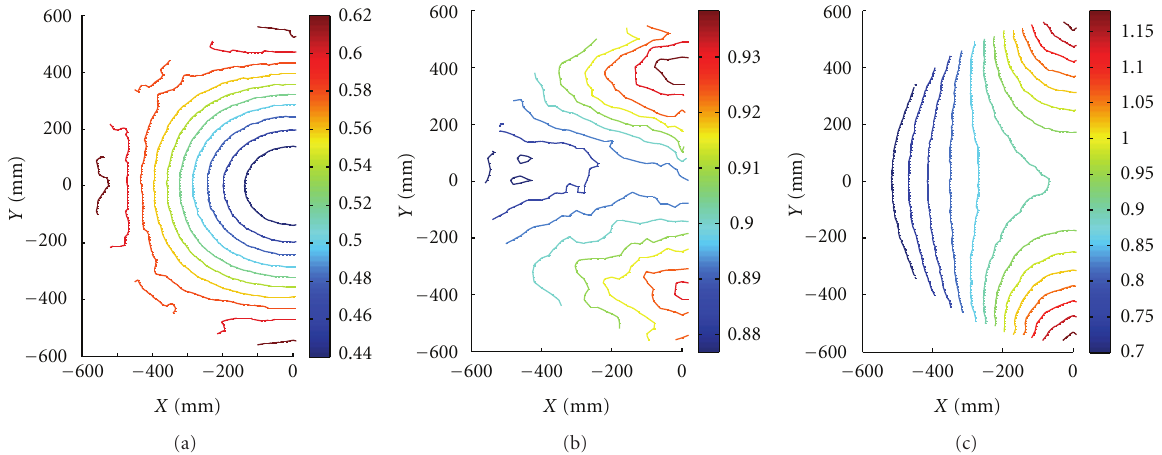
Figure 16: Manipulability index μ t (a), normalized velocity along the X direction (b), and DSI μ X computed in the horizontal half-plane XY with Z = − 800 mm (c).